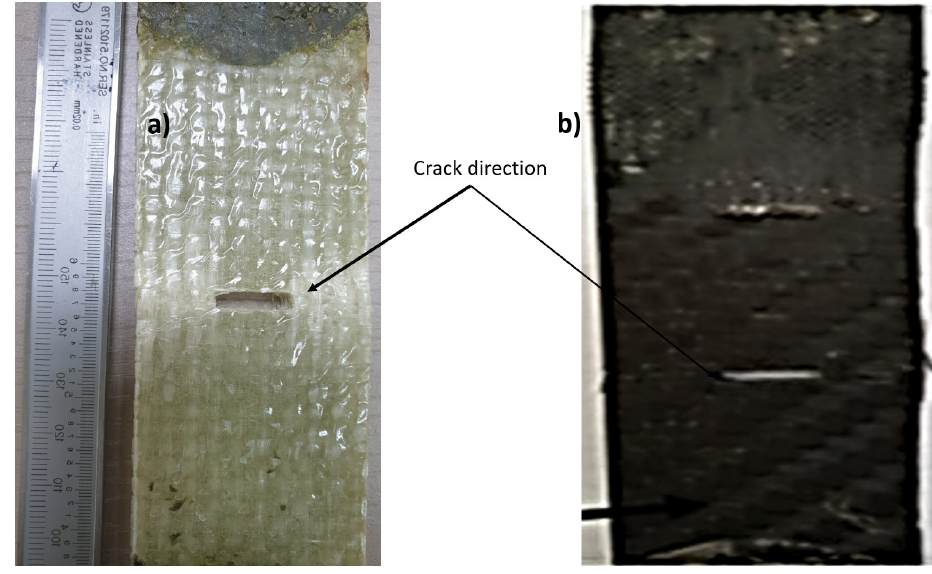
Figure 12. Failure modes for the center crack notch specimens; ( a ) glass fiber, ( b ) carbon